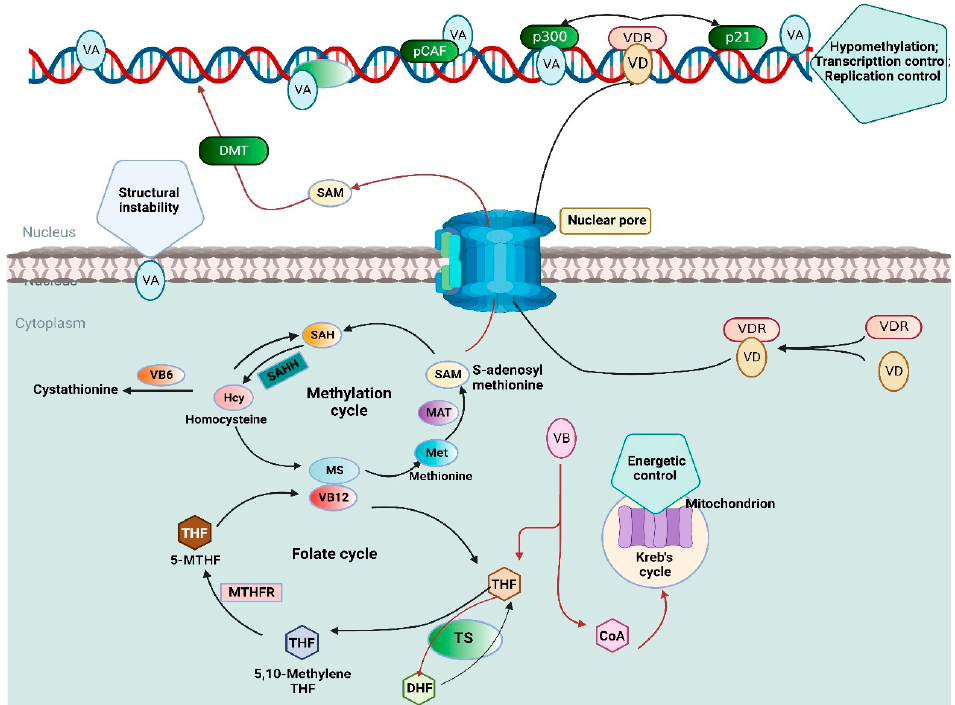
Figure 1. An overview of the impact of vitamin A, B complex, and D on cellular biochemistry. (Cre- ated with BioRender.com) CoA: Coenzyme A; DHF: Dihydrofolate; DMT: DNA methyltransferase; Hcy: Homocysteine; MAT: Methionine adenosyl transferase; MS: Methionine synthase;